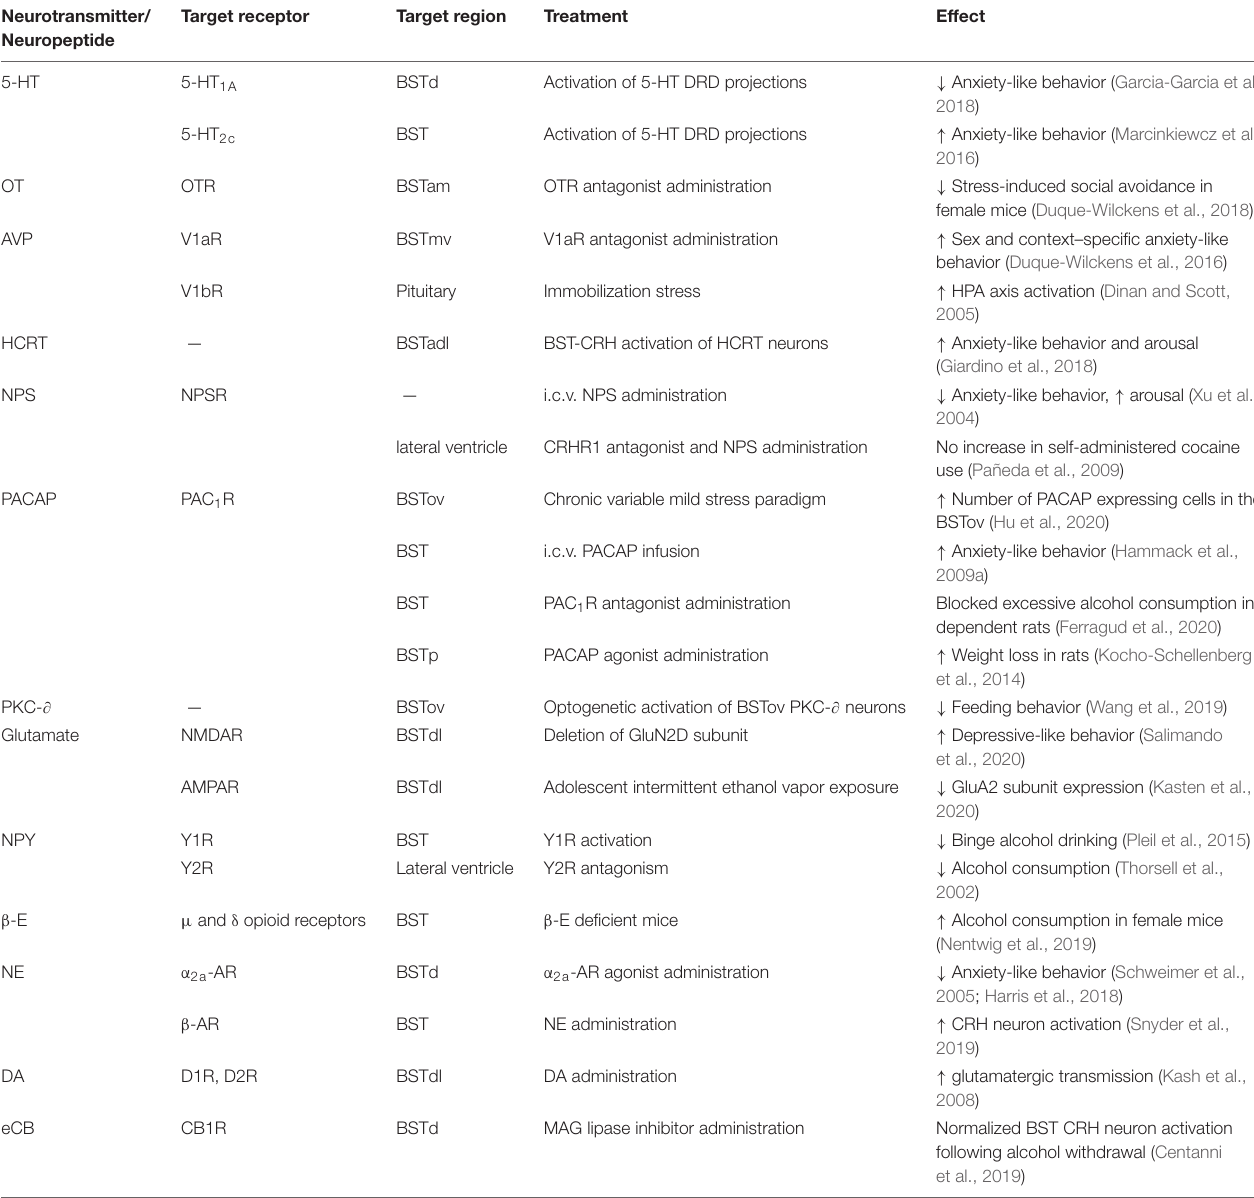
TABLE 1 | Summary of BST-CRH signaling